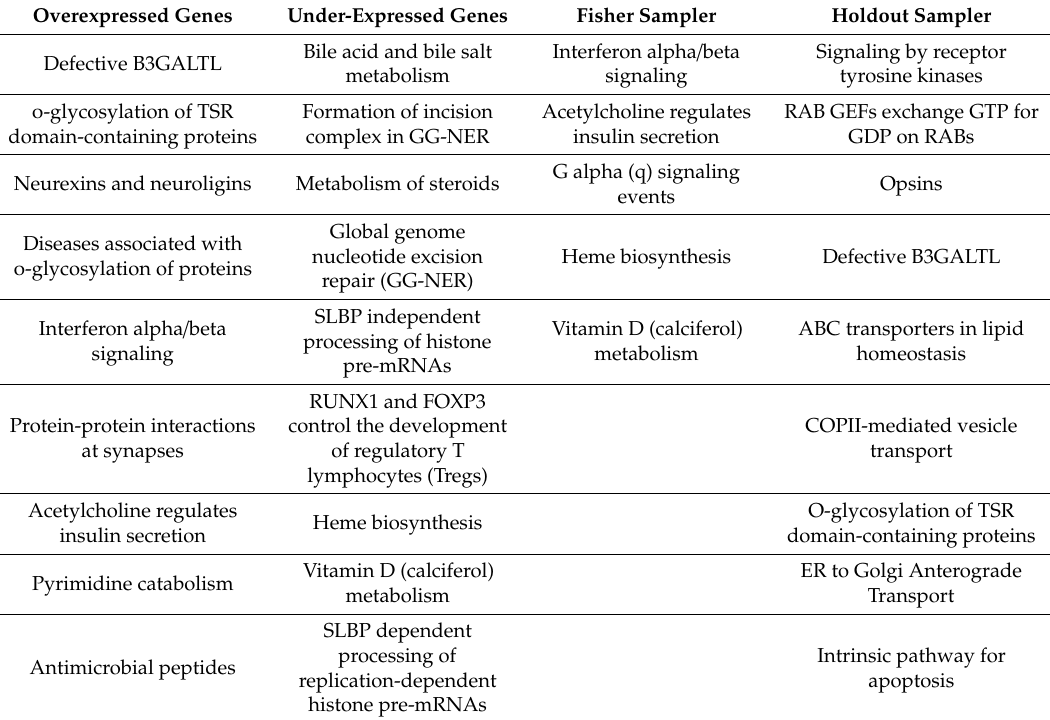
Table 1. GSE85837. Pathway analysis via Fisher’s ratio and holdout samplers. Overexpressed Genes Under-Expressed